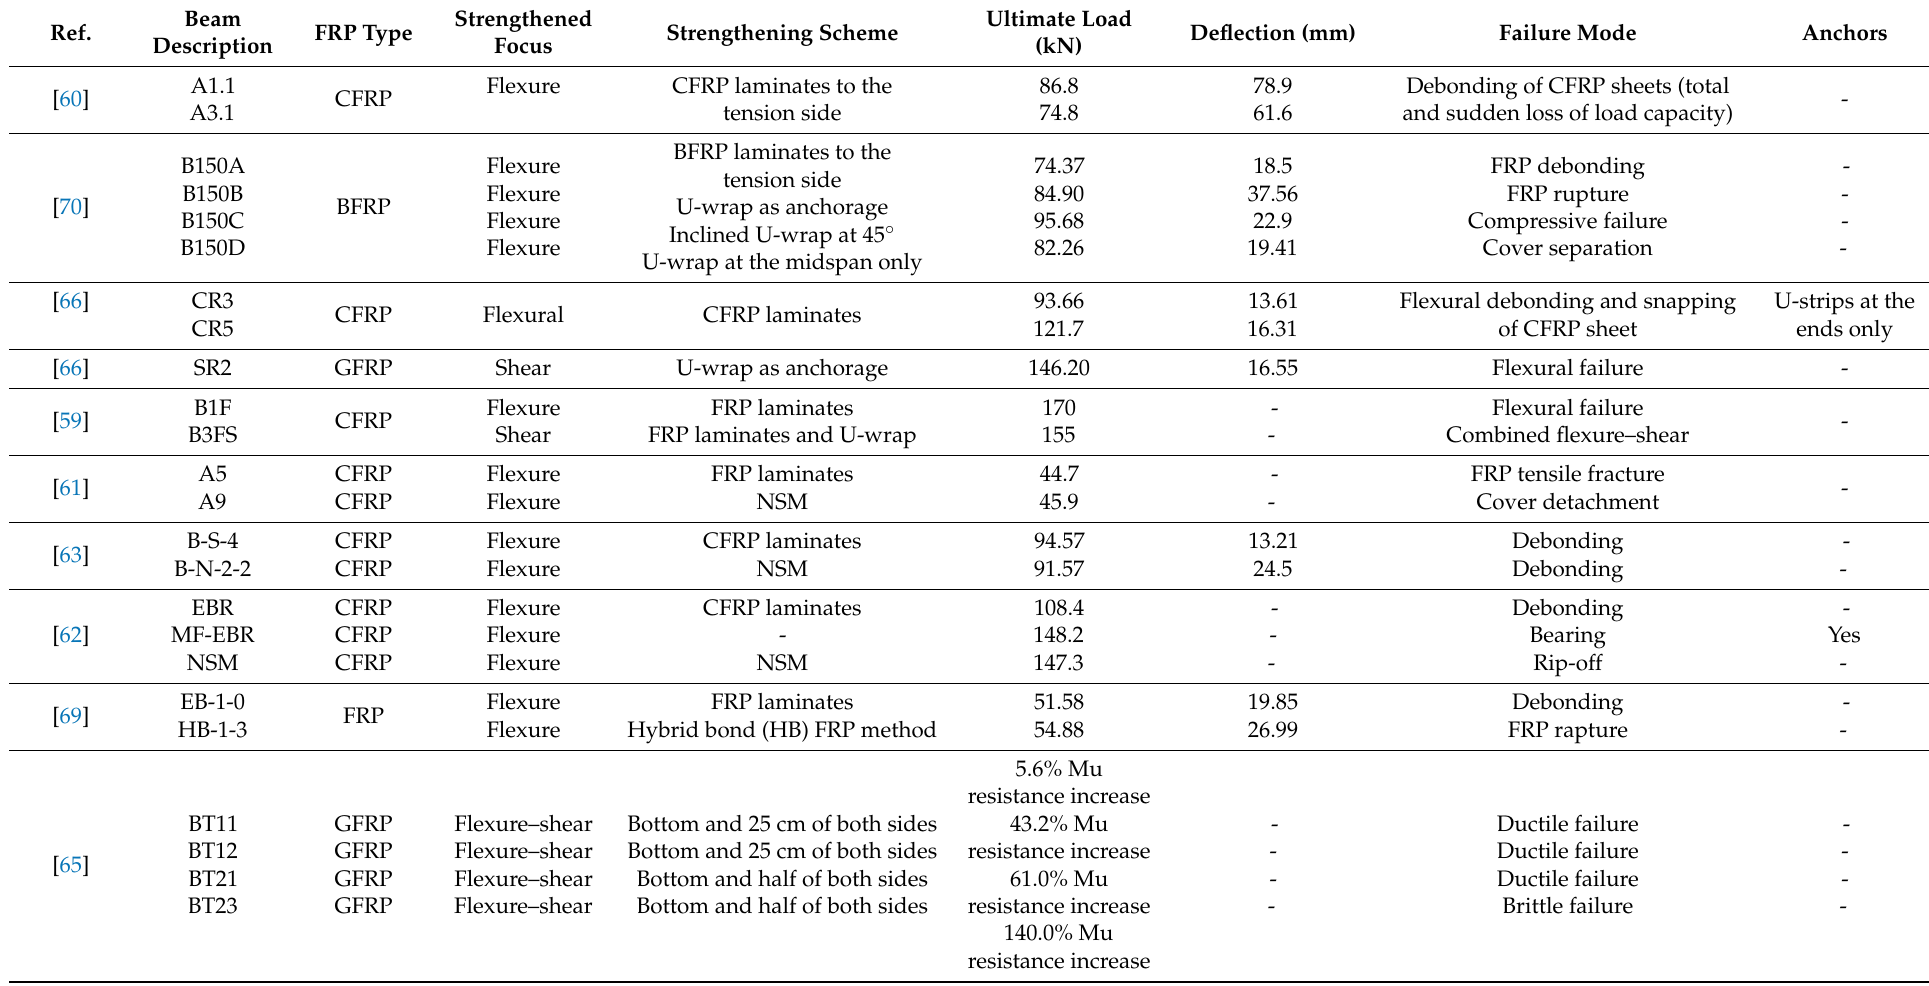
Table 3. Summary table of strengthened